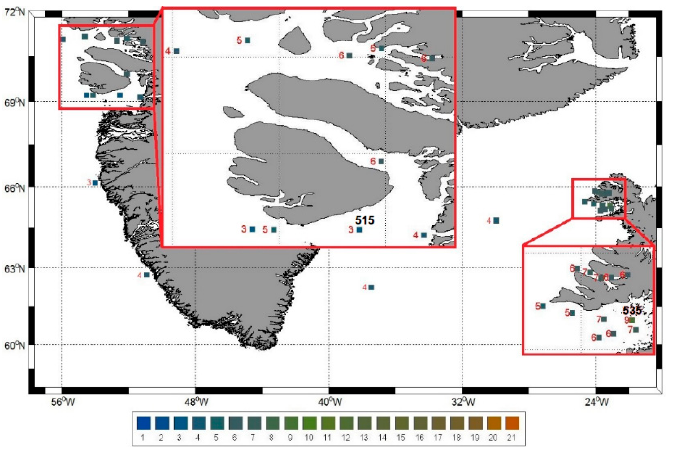
Figure 2. A FUI colour map of the visual observations from the west of Greenland and Iceland aboard R/V Maria S. Merian between 27 July and 8 August 2012.